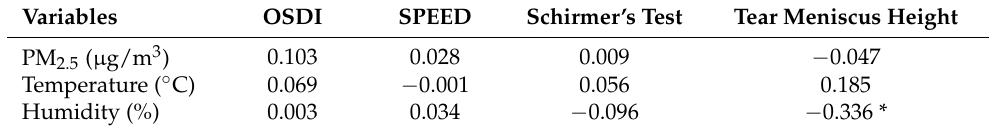
Table 3. Correlation coefficients among environment factors and dry eye metrics a